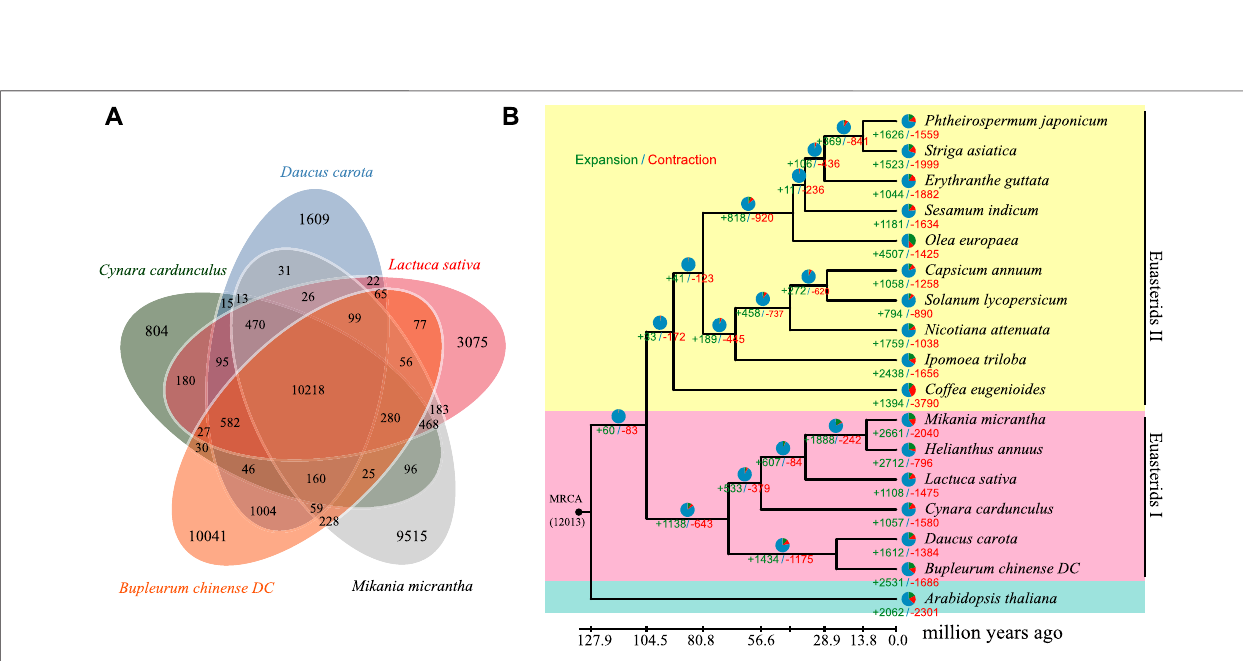
Frontiers in Genetics |